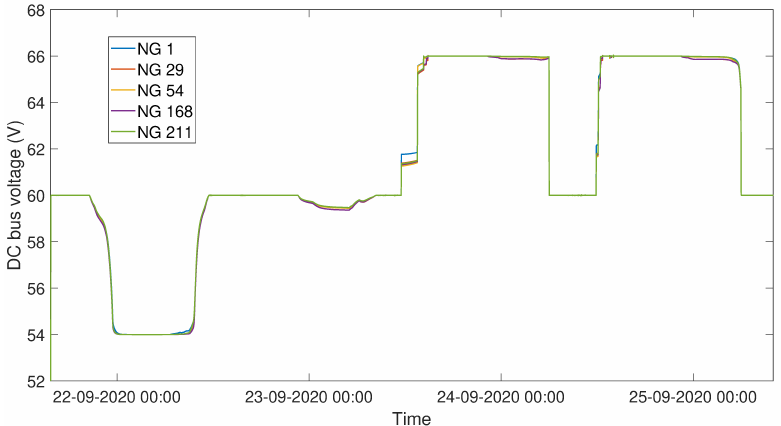
Figure 9. Evolution of the DC bus voltage—microgrid connection mode.